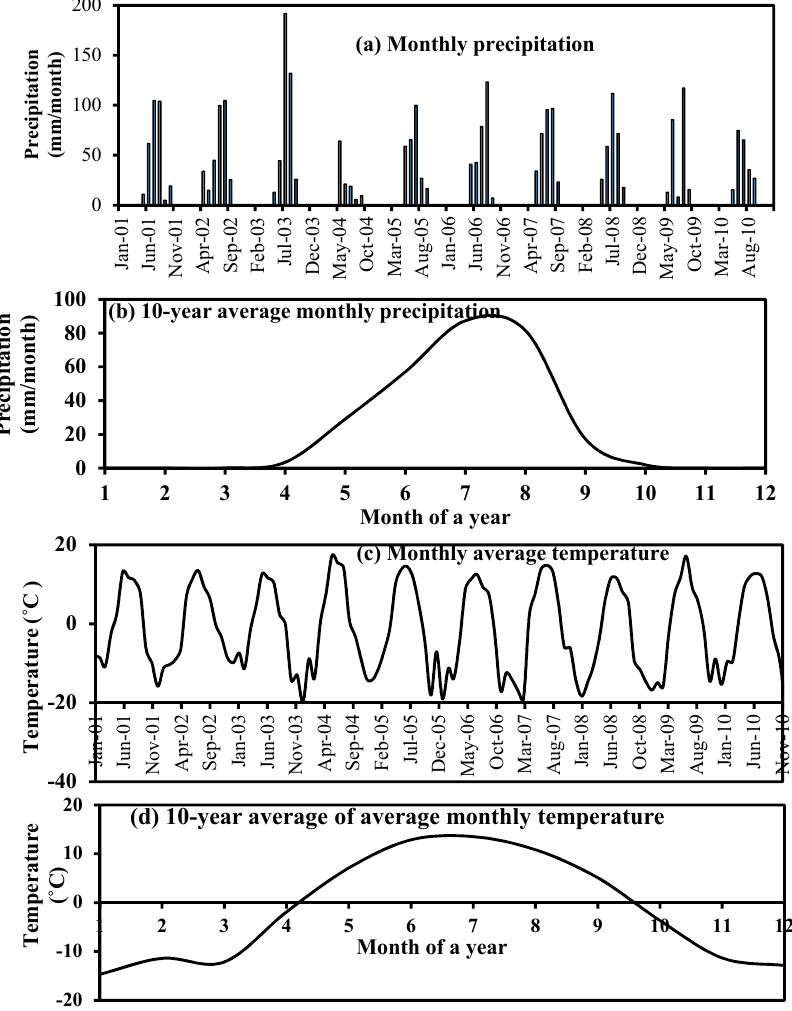
Figure 3. Graphical information of the monthly precipitation and temperature.